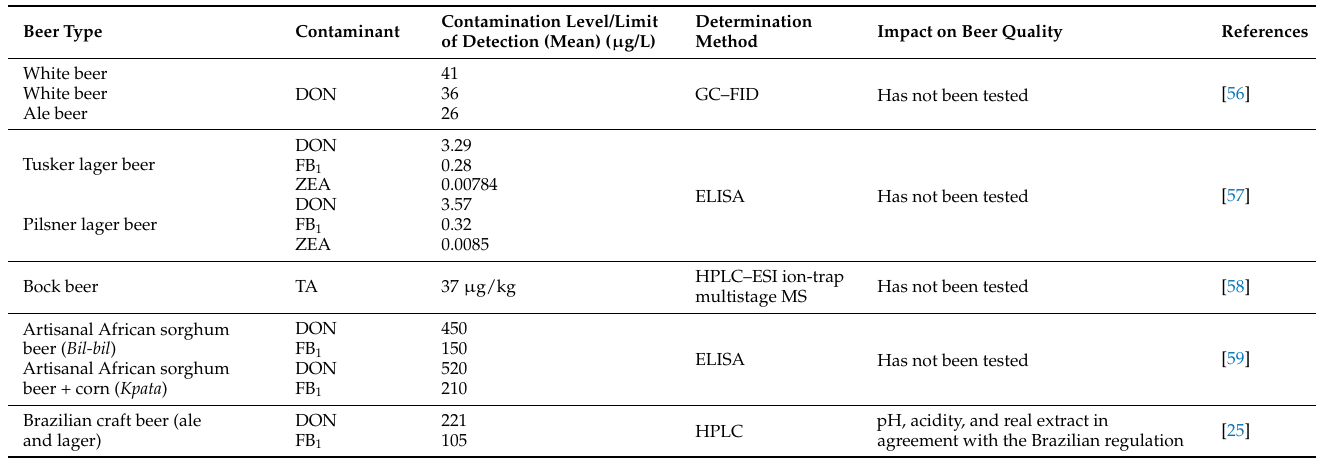
Table 3. Occurrence of detected mycotoxins in beers